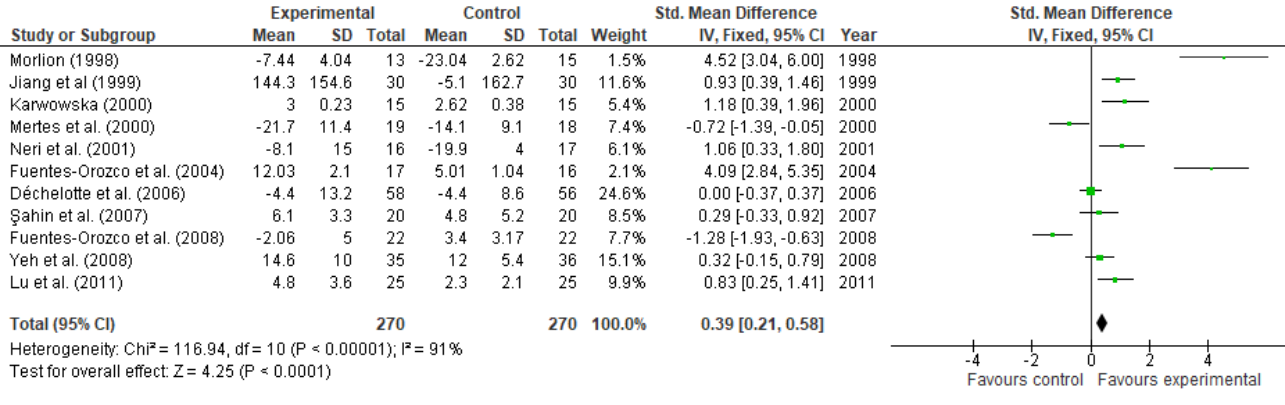
Figure 9. Nitrogen balance: fixed-effects meta-analysis and forest plot from studies providing supplementation of gluta- mine.